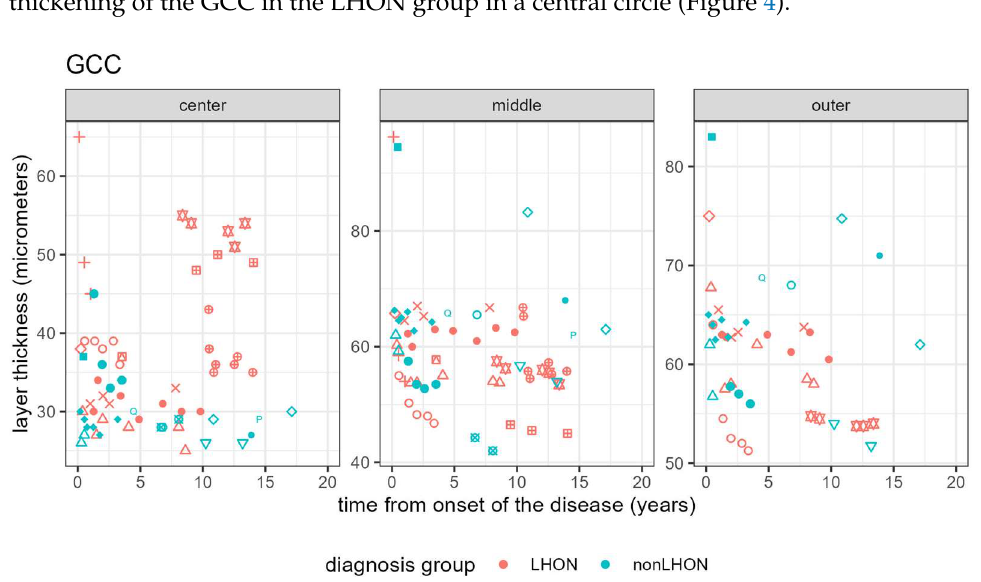
Figure 4. Longitudinal analysis of GCC thickness in ETDRS center, middle and outer ETDRS ring showing a trend of thickening in the center in the LHON group in the late chronic phase of the disease. Different symbols refer to a particular patient, symbols in red belong to the LHON patients, whilst nonLHON patients are marked with green symbols.